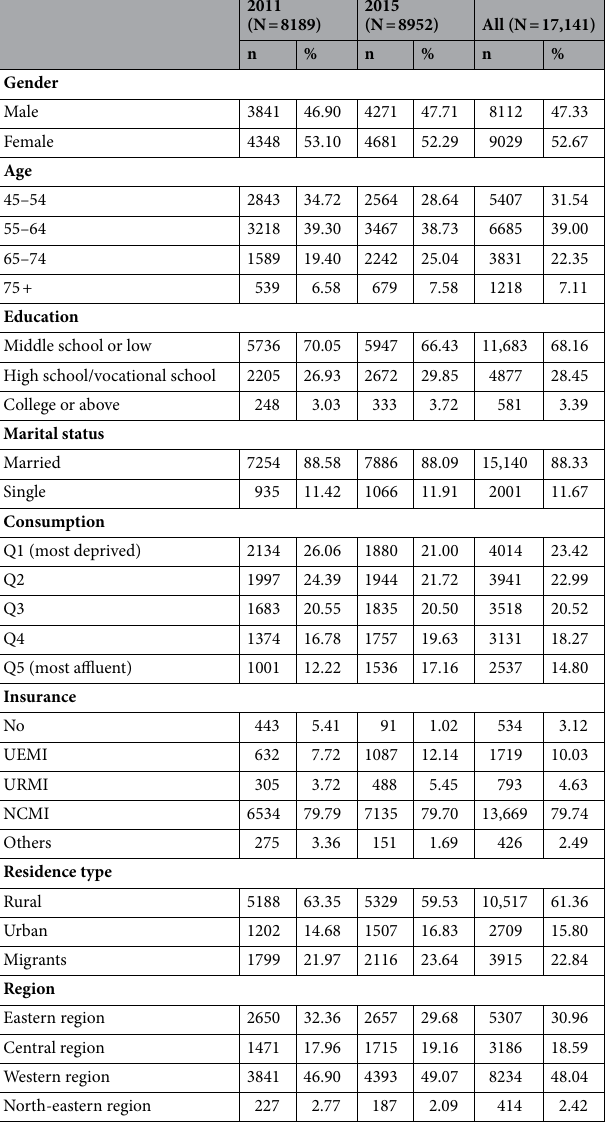
Table 1. Demographic characteristic participants in year 2011, 2015 and overall sample. UEMI urban employee medical insurance, URMI urban resident medical insurance, NCMI new cooperative medical insurance. This table provides the distribution of demographic characteristics of participants in year 2011, 2015, and